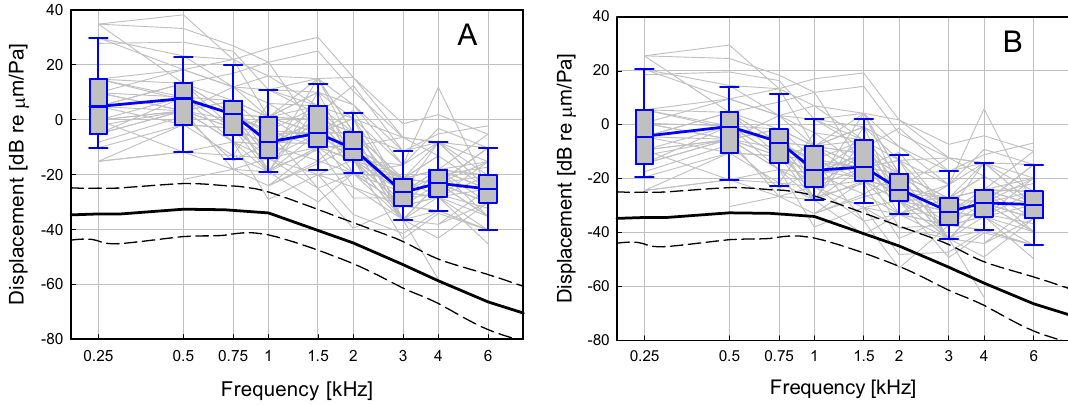
Figure 4. Estimated piston displacement of all patients (N = 77) that evokes a perception equivalent to a sound stimulation of 94 dBSPL at the tympanic membrane. Panel ( A ) shows the median piston displacement (blue) if an electro-mechanic transfer function of the actuator as measured unloaded on the bench is assumed. Panel ( B ) shows the same as before but for an electro-mechanic transfer function corrected for intraoperative conditions. In both panels piston displacements of individual patients as shown as thin grey lines. Box plots show median responses with the 25th/75th percentile range and whiskers depict the 5th/95th percentiles. The solid black line depicts the average stapes footplate displacement in normal ears at 94 dB SPL and the dashed black lines the 5th/95th percentile range 8 .